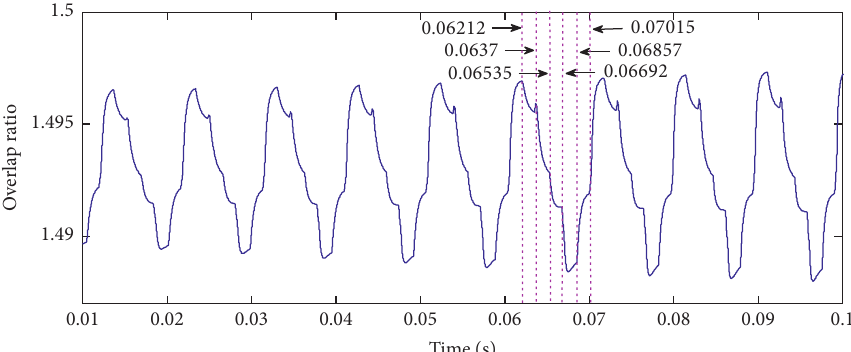
Figure 12: Time-varying overlap ratio of s- p